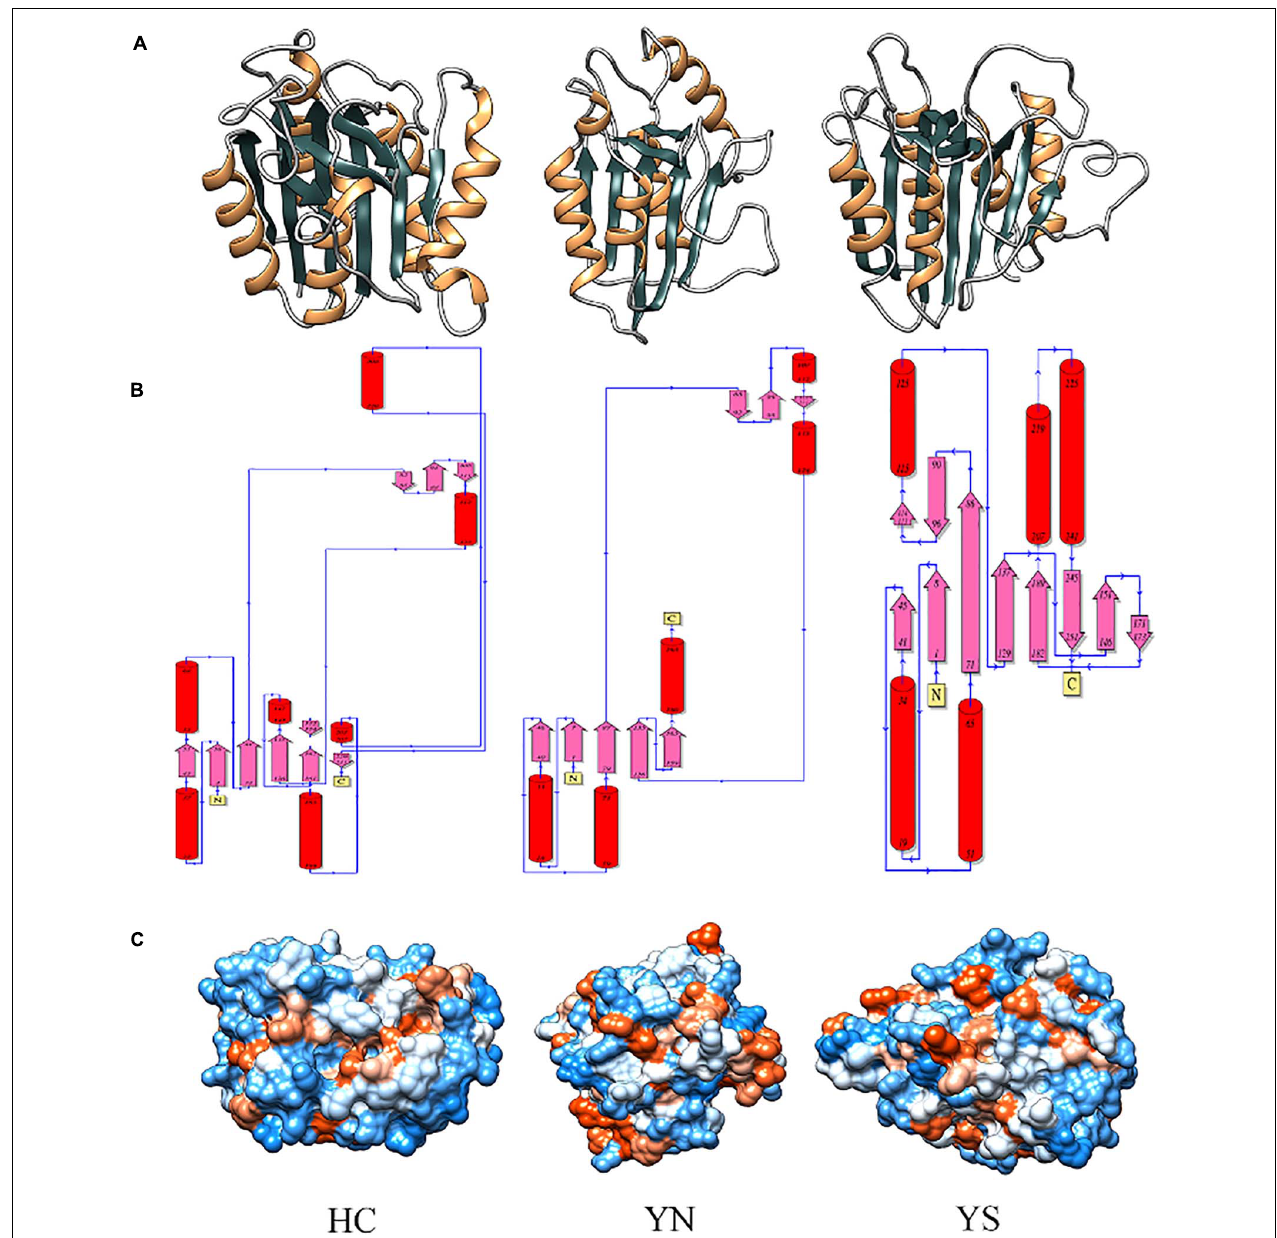
FIGURE 5 | Comparing and analyzing the homology models of WP_010999143.1 (HC), WP_010997820.1 (YN), and WP_010999263.1 (YS) of Nostoc sp. PCC 7120, where HC is the wild-type OCA whereas YN and YS are pseudo orthocaspases. (A) 3D models of putative orthocaspases showing a conserved caspase-hemoglobinase fold (CHF). HC, YN, and YS possessed identical topology (B) due to conserved CHF with four parallel β -sheets and three α -helices. (C) Hydrophobicity surface view of modeled orthocaspases, where blue and orange colors represented hydrophilic and hydrophobic residues, respectively. Note that for WP_010997820.1 (YN) and WP_010999263.1 (YS), only the Peptidase C14 domain has been modeled due to template unavailability, while the full-length homology model was constructed for WP_010999143.1